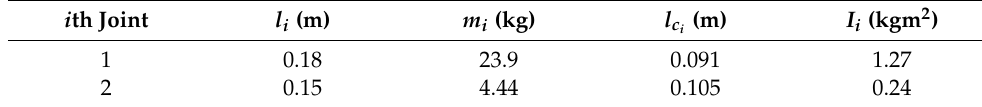
Table 1. Parameters of the 2-DOF robot manipulator.